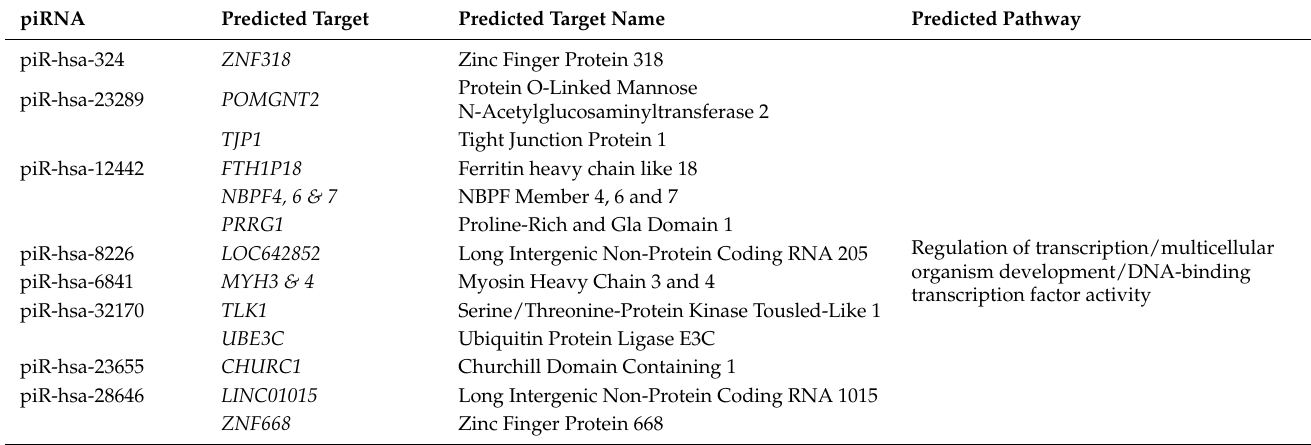
Table 2. piRNA downregulated in iPSCs that showed higher efficiency in reprogramming.